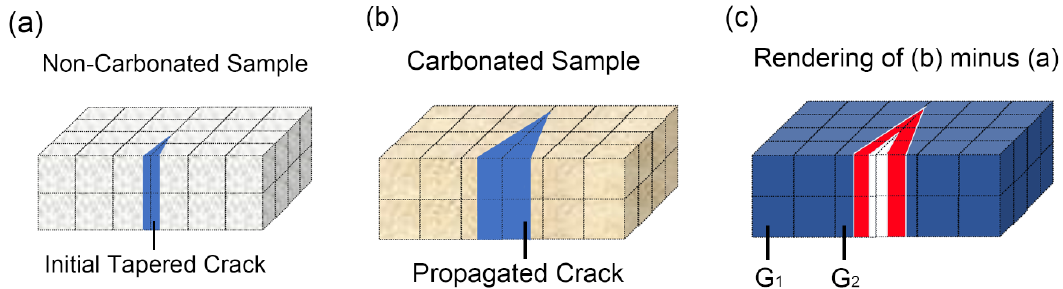
Figure 8. Schematic diagram for the identification of cracks: ( a ) represents typical local area before carbonation; ( b ) represents the identical local area as ( a ) after carbonation; and ( c ) represents the subtracted renderings through ( b ) minus ( a ). The volume of each cubic within the mesh equals the size of one voxel.